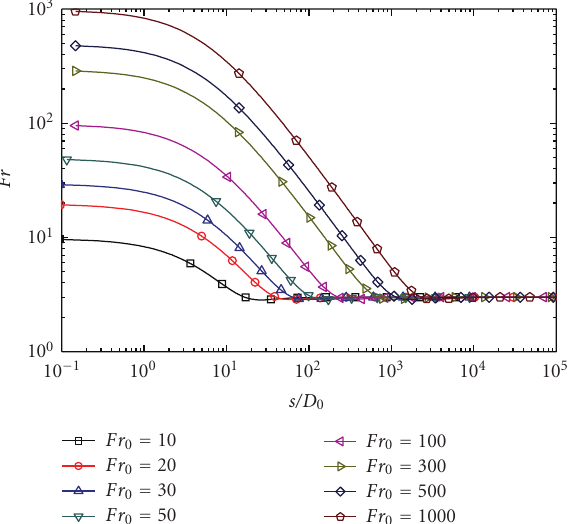
Figure 9: Trajectories of horizontal buoyant jet with large density